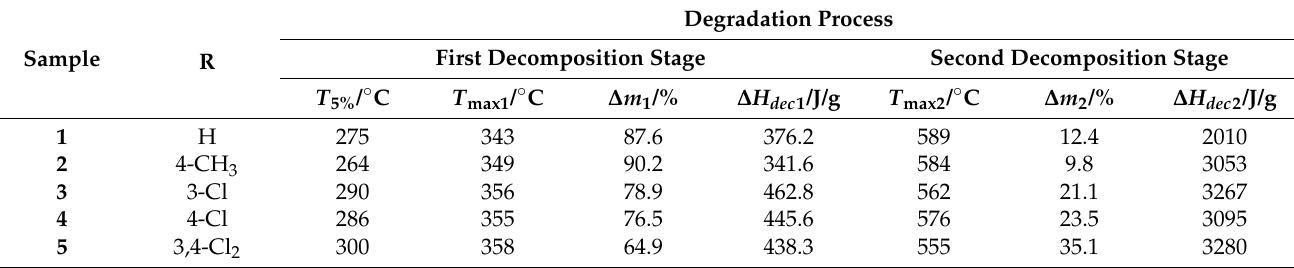
Table 3. The TG/DTG data for compounds 1 – 5 (a synthetic air